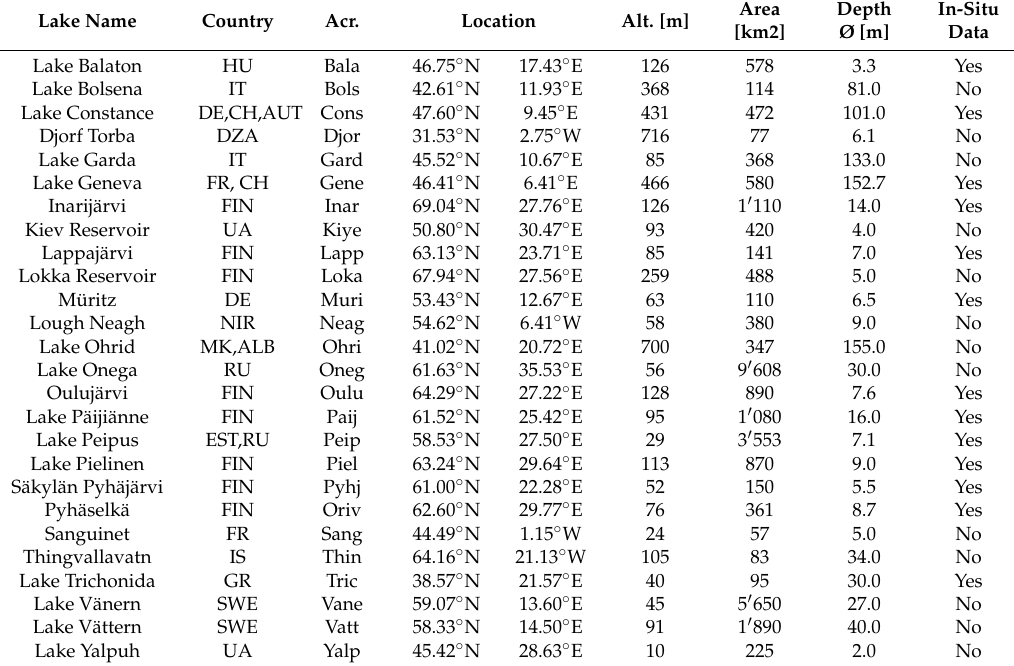
Table 1. List of Lakes where LSWT was retrieved and trend analysis performed. The acronyms are the same as those used in Figure 1.